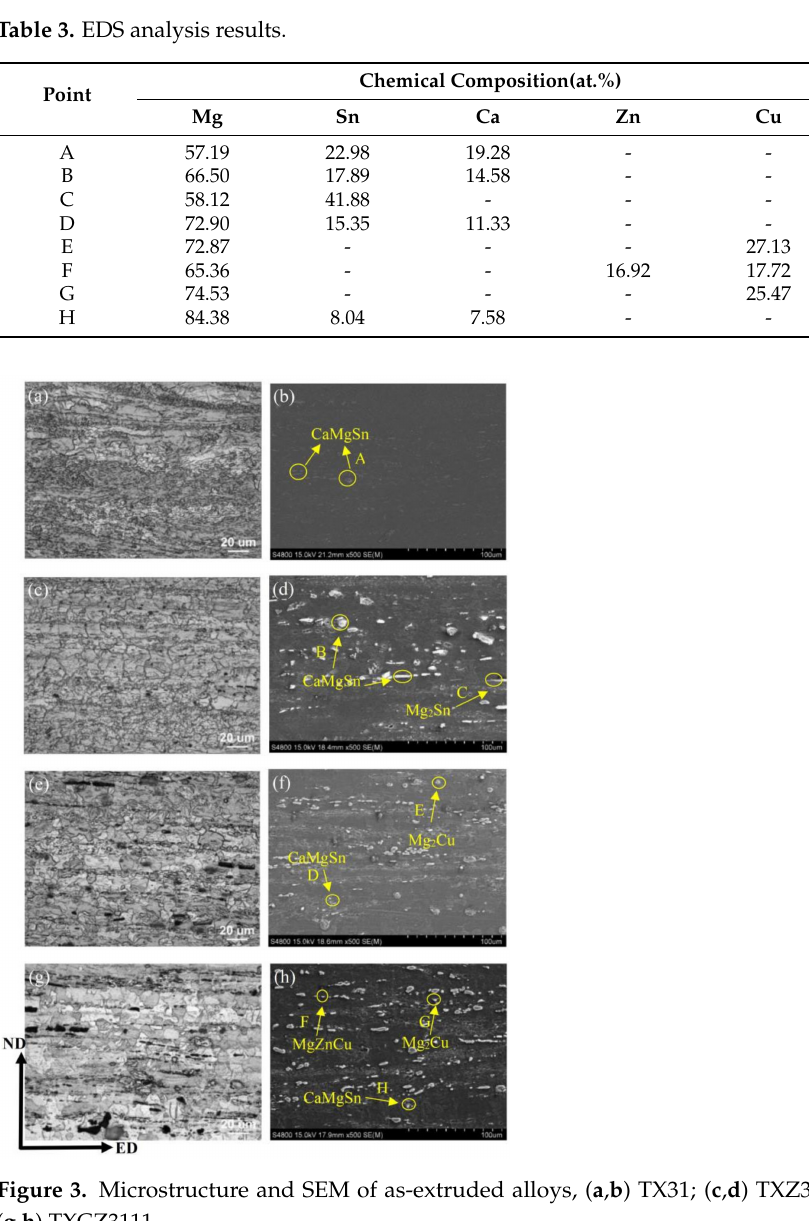
Figure 3. Microstructure and SEM of as-extruded alloys, ( a , b ) TX31; ( c , d ) TXZ311; ( e , f ) TXC311; ( g , h )